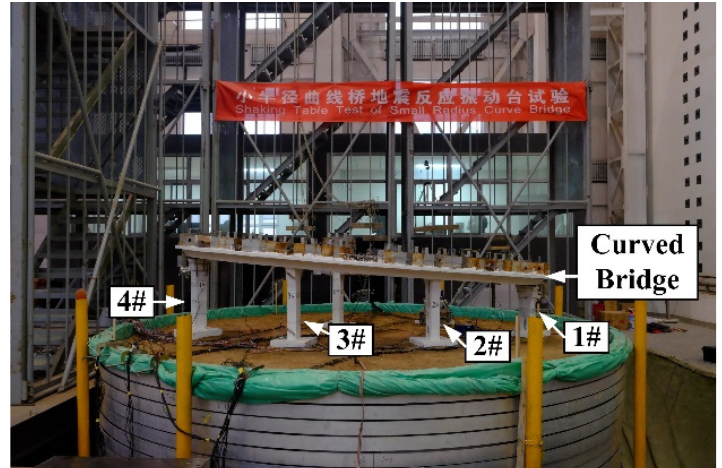
Figure 1. Layout of the shaking table test.